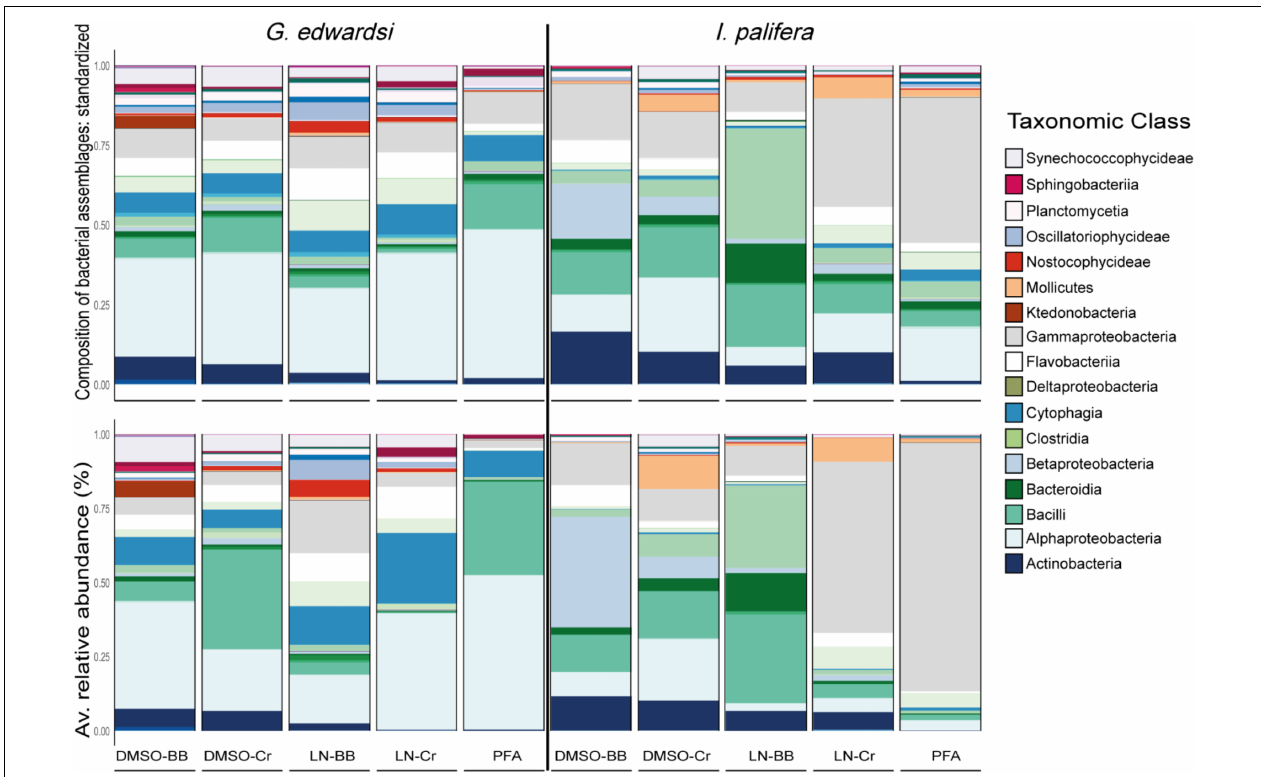
FIGURE 6 | Bacterial assemblage composition (top) and structure (bottom) among preservation and homogenization methods in G. edwardsi (left) and I. palifera (right). The taxonomic composition is consistent among methodologies for G. edwardsi (top left); however, the taxonomic structure is distorted when evaluated using relative abundance (bottom left). For I. palifera , the taxonomic composition is not consistent across methodologies, with major discrepancies in classes Gammaproteobacteria, Clostridia, Betaproteobacteria, Bacilli, Alphaproteobacteria, and Actinobacteria (top right). Discrepancies are enhanced when relative abundance is considered (bottom right). For results by colony see Supplementary Figure 5 . Major taxonomic classes are presented in the legend, for complete legend see Supplementary Figure 6